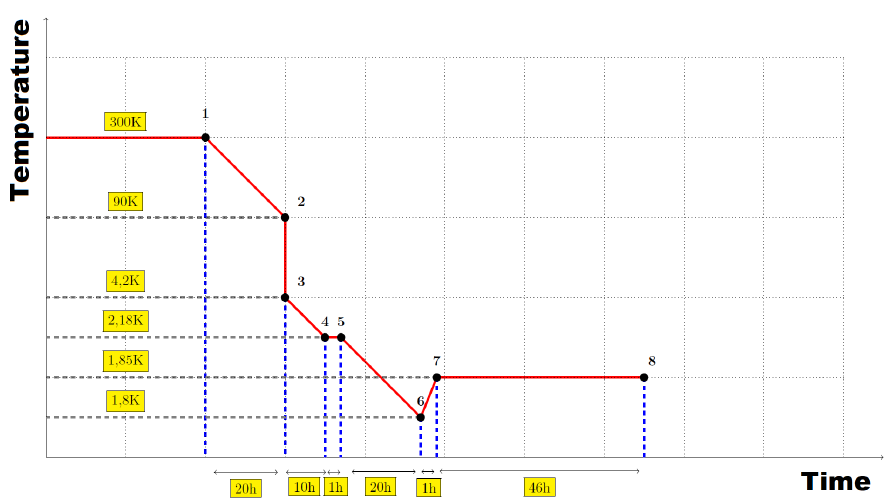
Figure 5. Schematic presentation of cooling process: 1–2, helium container cooling; 2–3, liquid helium overflow; 3–4, cooling to T λ ; 4–5, lambda front [10]; 5–6, cooling of the system to the filtration temperature of 1.8 K; 6–8, quantum filtration via the fountain